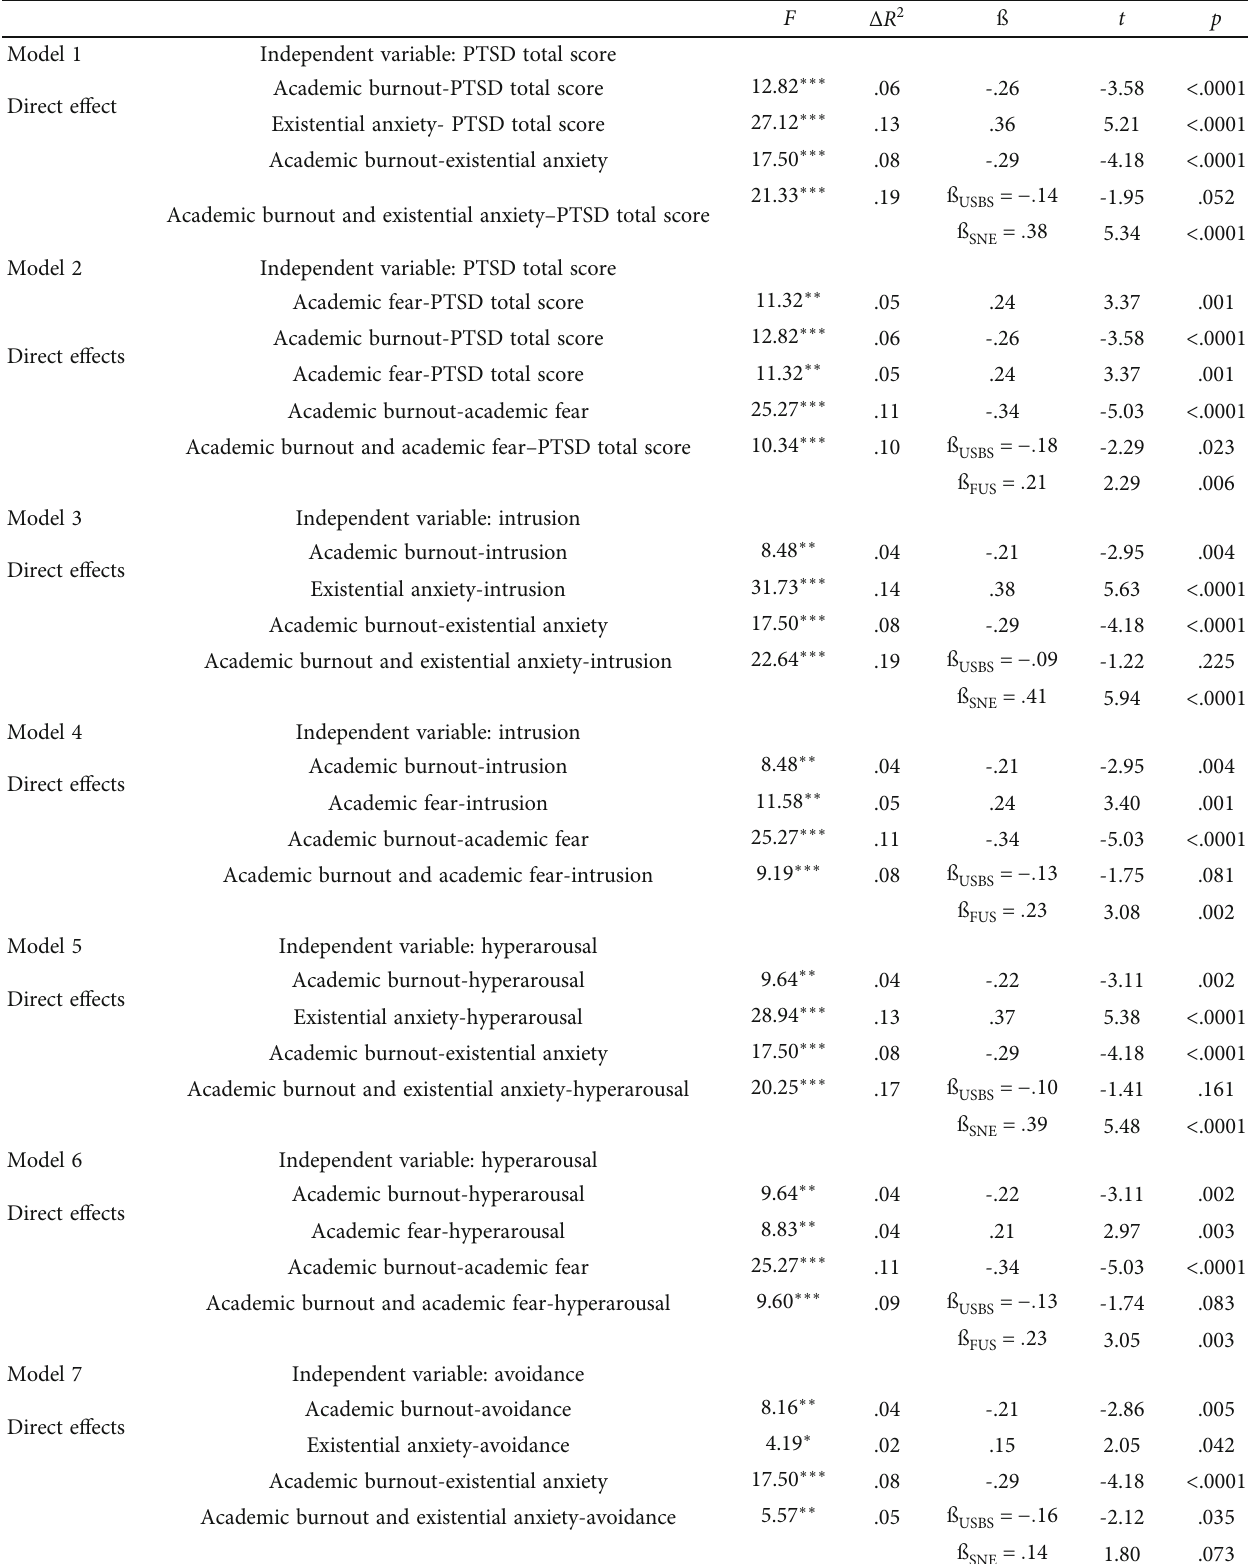
Table 4: Simple mediation analysis – direct e ff